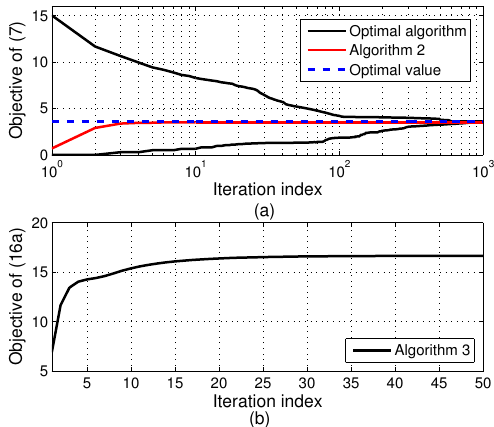
Figure 2. Convergence of the proposed algorithms over a typical random channel realization. ( a ) EE of Algorithms 1 and 2; ( b ) Objective of problem P 3 with α = 2.90 (at the 2nd iteration of Algorithm 2 in Figure